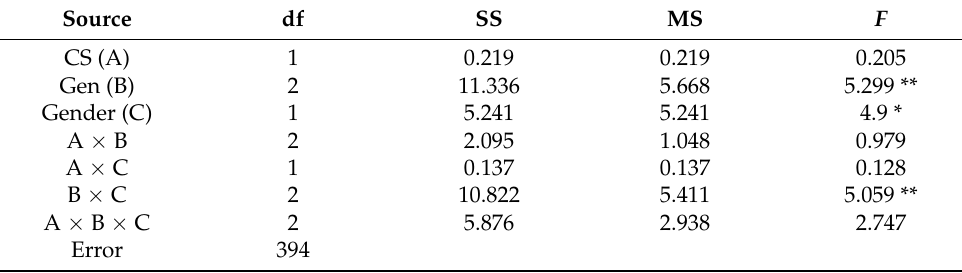
Table 7. Three-way ANOVA for involvement (Inv).